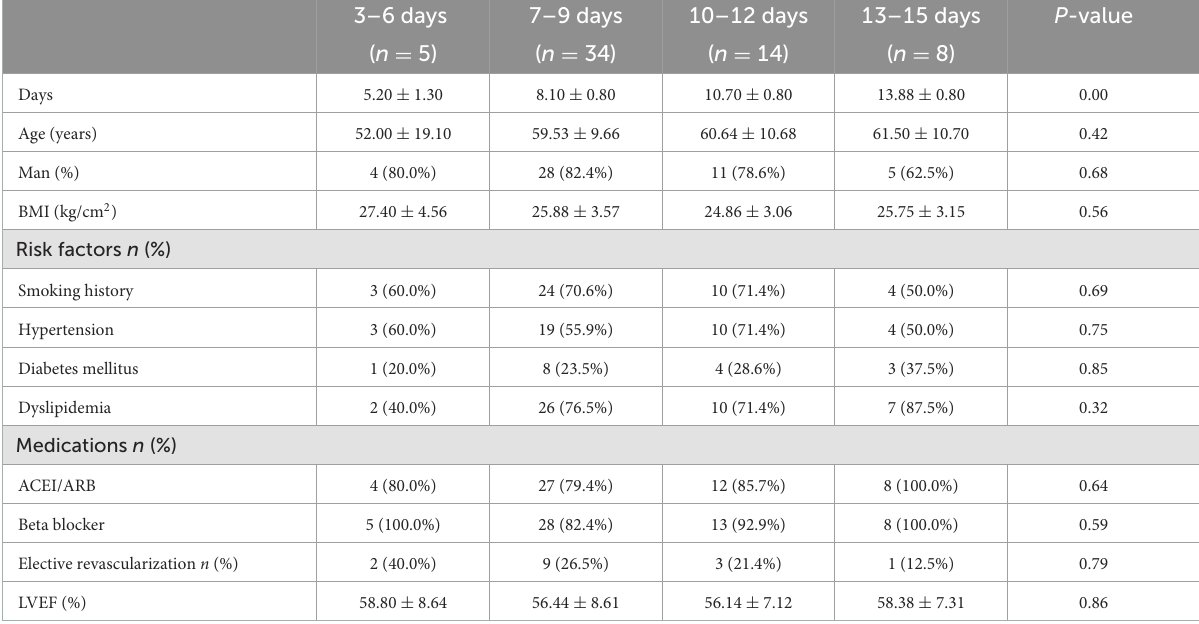
TABLE 1 General clinical